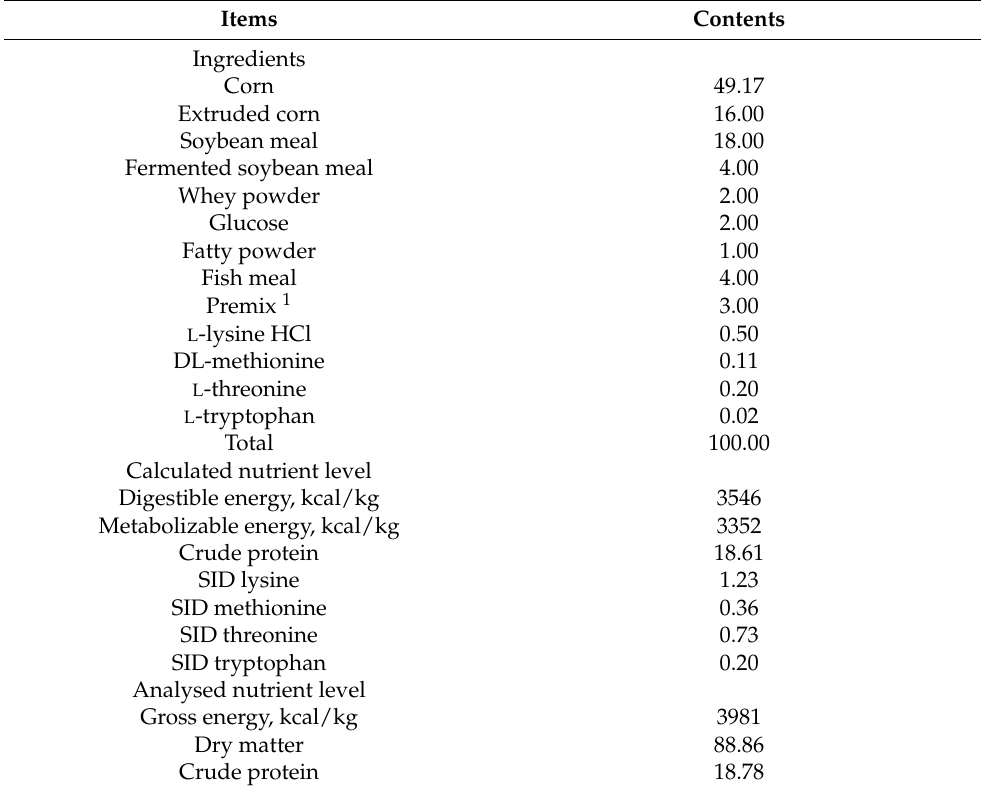
Table 1. The ingredient composition and nutrient levels of the basal diets (as-fed basis,